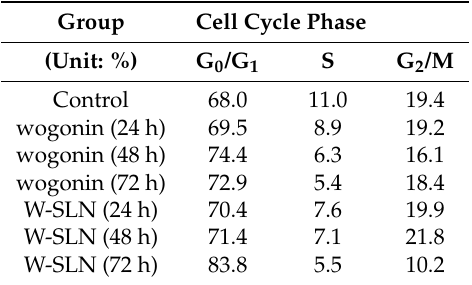
Table 3. Cell cycle distribution of MCF-7 cells treated with wogonin or W-SLN for 24, 48, and 72 h. Group Cell Cycle Phase (Unit: